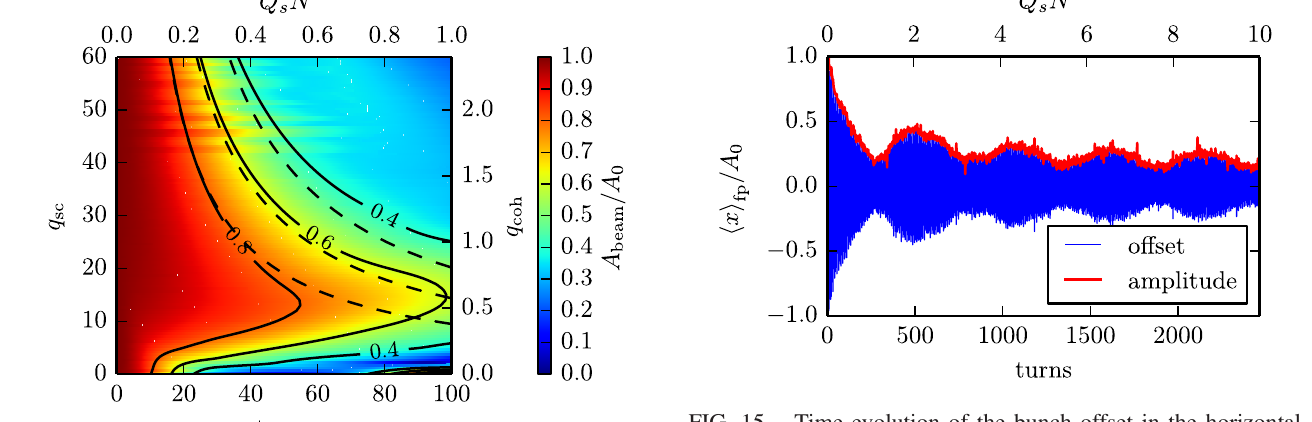
FIG. 15. Time evolution of the bunch offset in the horizontal plane from BPM measurements in SIS18 after a transverse kick. One turn corresponds to 1 . 682 μ s, A 0 ≈ 4